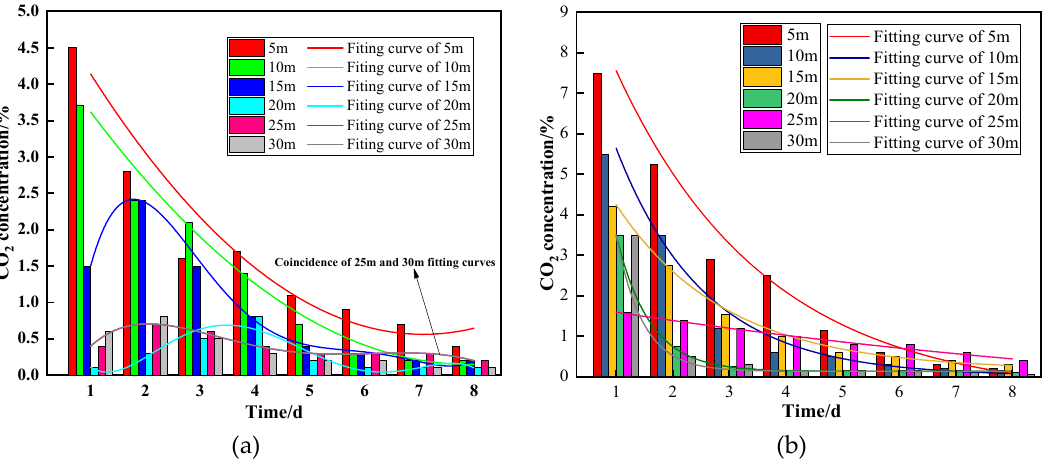
Figure 10. The change in CO 2 concentration in inspection hole ( a ) The change of CO 2 concentration during low-pressure injection and ( b ) The change of CO 2 concentration during medium-pressure injection. Table 5. The fitting parameters of CO 2 concentration during low-pressure injection. y 0